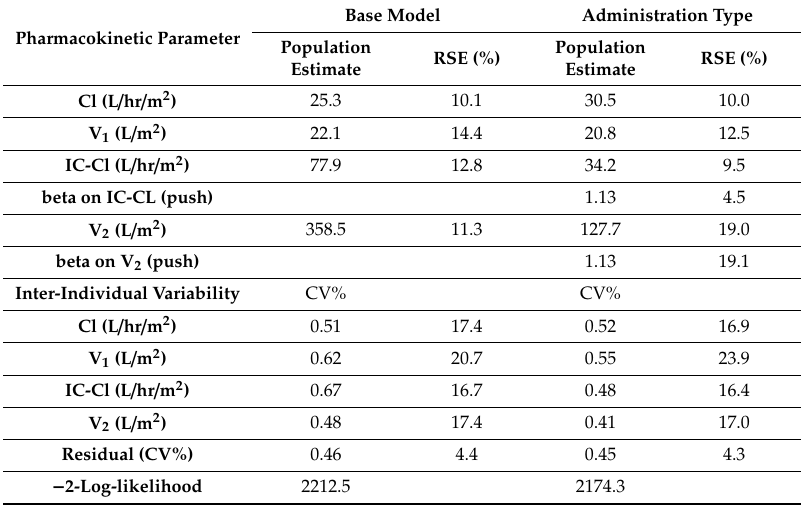
Table 2. Population pharmacokinetics of vincristine.